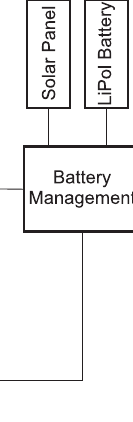
Figure 2. Internal structure of the accelerometer wireless sensor node with the LIS2DW12 sensor.